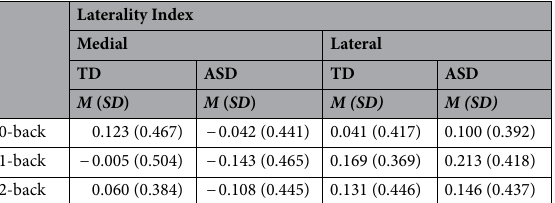
Table 4. Functional connectivity laterality index of ASD and TD individuals during n-back task.